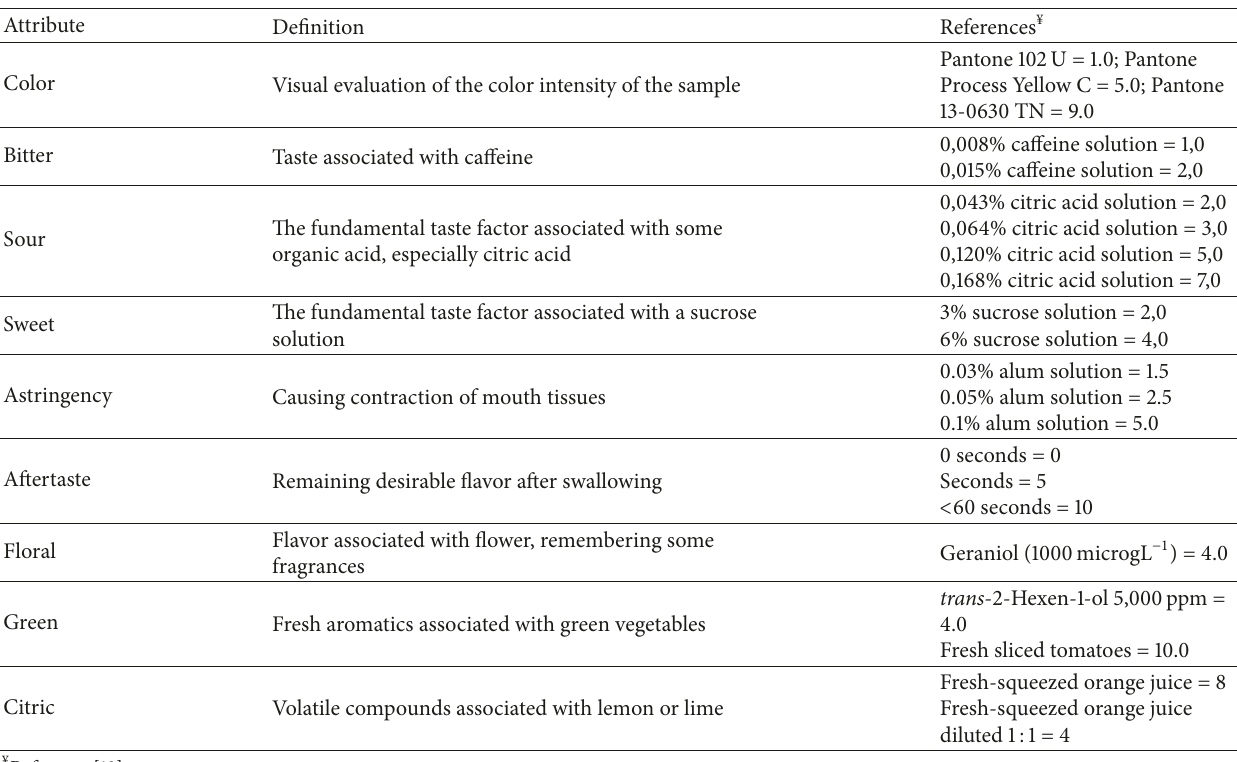
Table 6: Flavor attributes selected for descriptive sensory analysis.